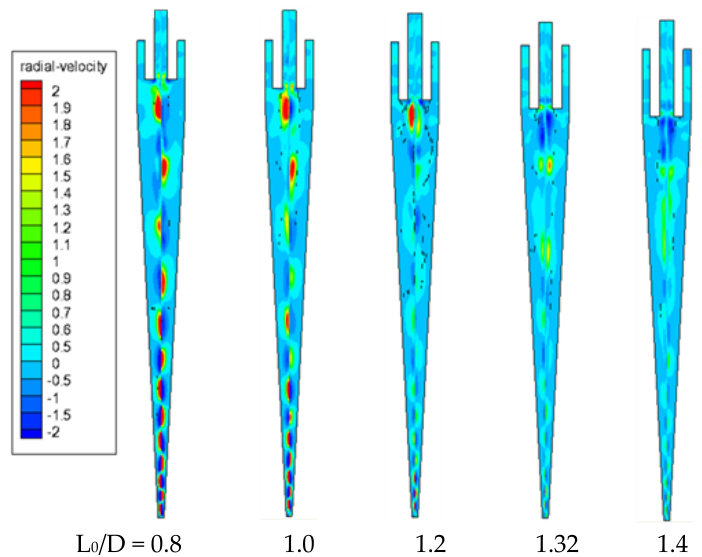
8 of 17 Figure 5. Comparison chart of separation efficiency between simulation and experiment. 4. Results and Discussion 4.1. Continuous Phase Cloud maps with flow field information and velocity of continuous phase on seven Z-axial positions of mini-hydrocyclones can be extracted from the CFD simulation file. The seven Z-axial positions are shown in Figure 1. The flow field information can be qualitatively analyzed using cloud maps; it also can be quantitatively analyzed by the velocity data. 4.1.1. Analysis of Radial Velocity Simulation It can be observed from the radial velocity cloud diagram in Figure 6 that the radial velocity is much smaller than axial and tangential velocities. The deeper the vortex finder inserts, the smaller the radial velocity is. Radial velocity determines the radial migration